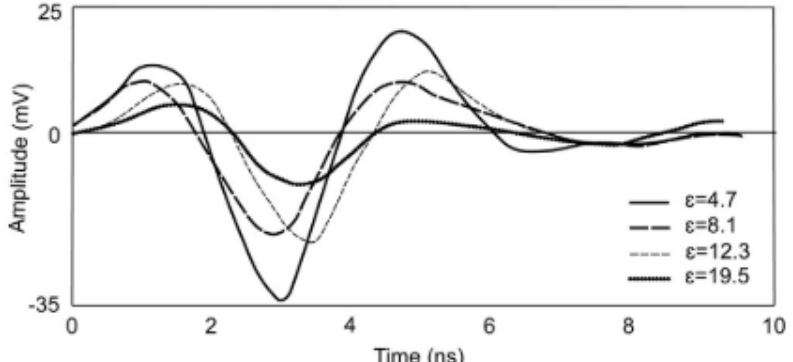
Figure 7. Influence of soil permittivity on the amplitude of the early − time signal (modified version from [65]). Adapted with permission from [146]. Copyright 2019, Elsevier.